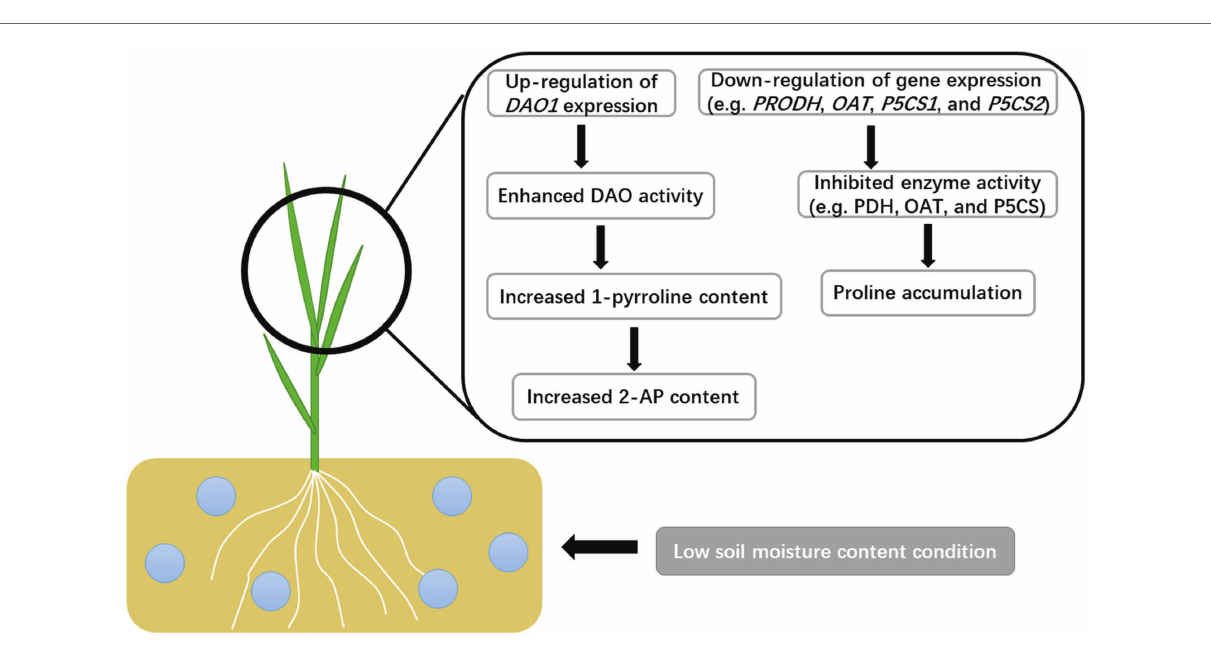
FIGURE 7 | The potential mechanism of soil moisture in regulating the 2-AP biosynthesis in fragrant